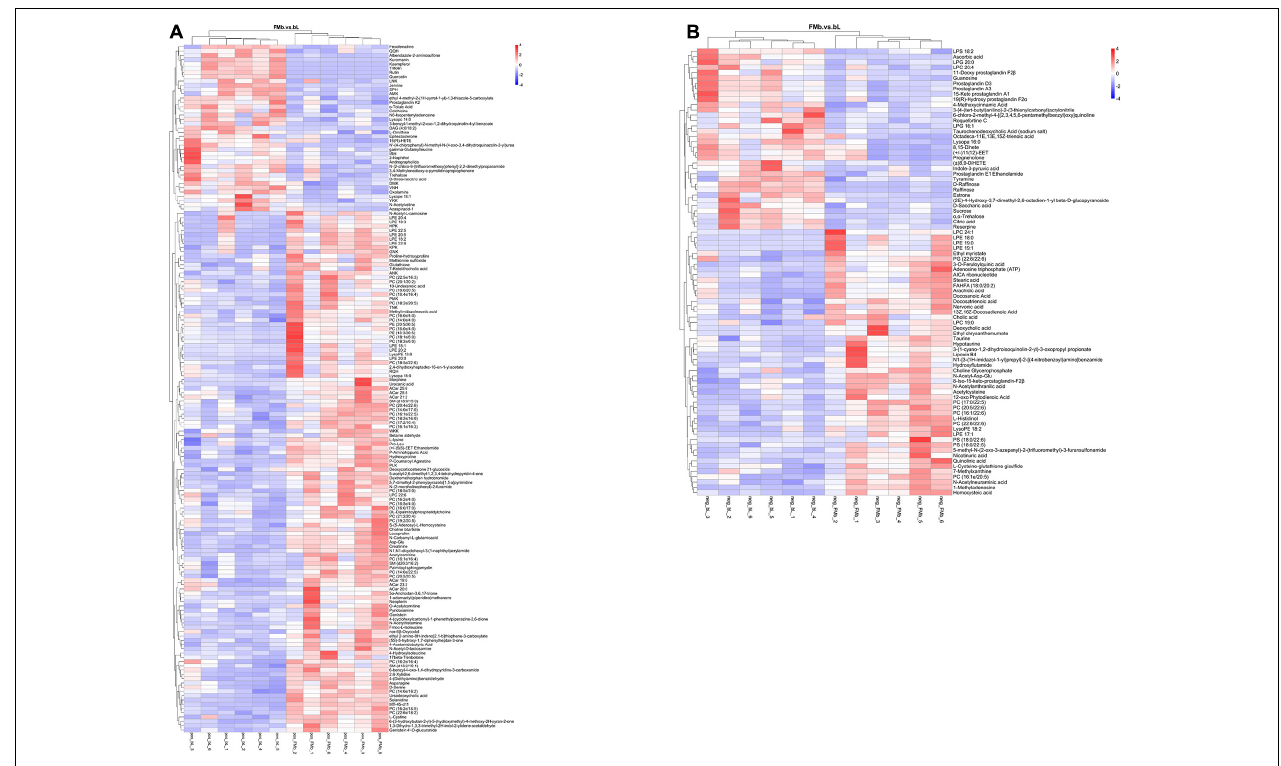
FIGURE 6 | Hierarchical clustering analysis of the DMs in FMb vs. bL: positive (A) and negative (B) ions. Red and blue indicate that the DMs were upregulated and downregulated, respectively.